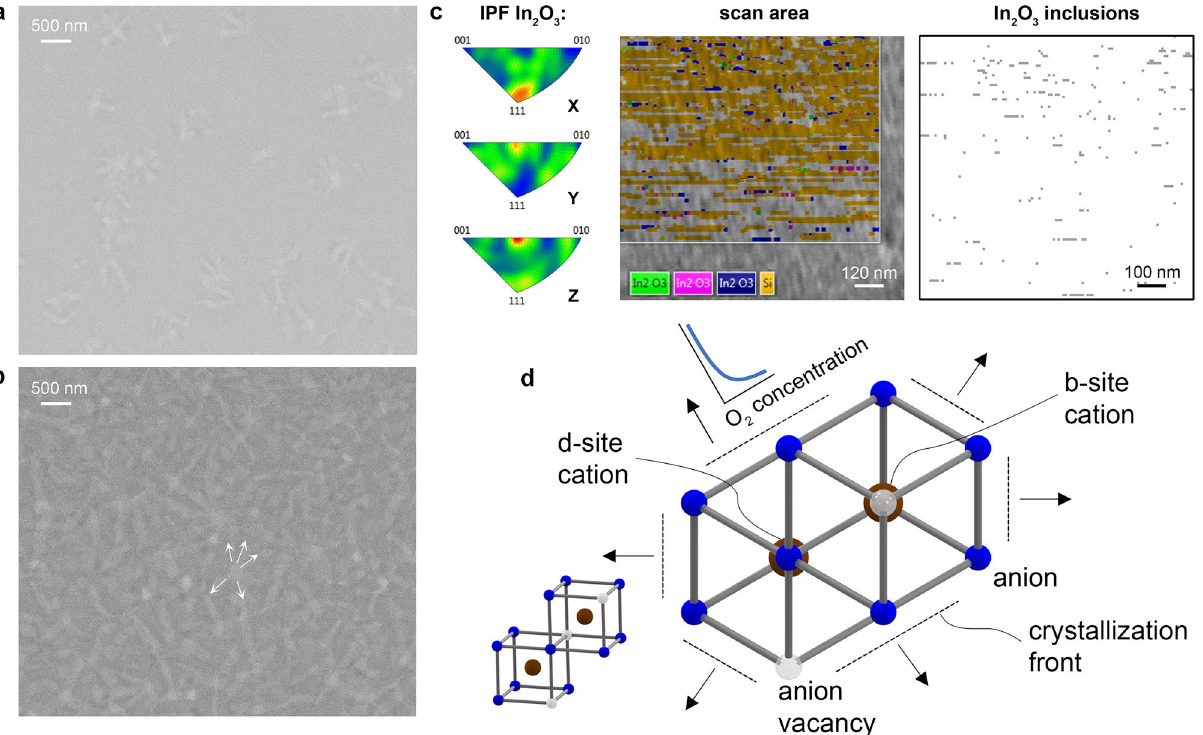
Figure 3. 20 nm-thick ITO films (room temperature IBAE in an Ar/O 2 mixture 2/10 sccm) with different annealing temperatures: ( a ) 300 °C—crystalline structure with inclusions of amorphous phases; ( b ) 320